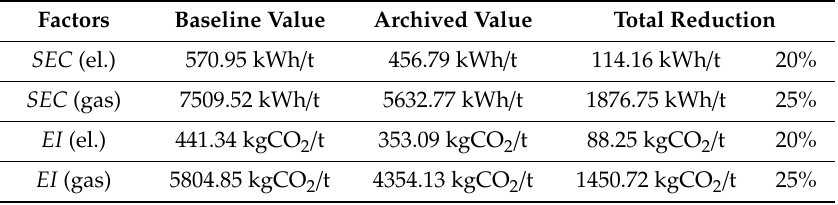
Table 3. The total reduction of SEC and